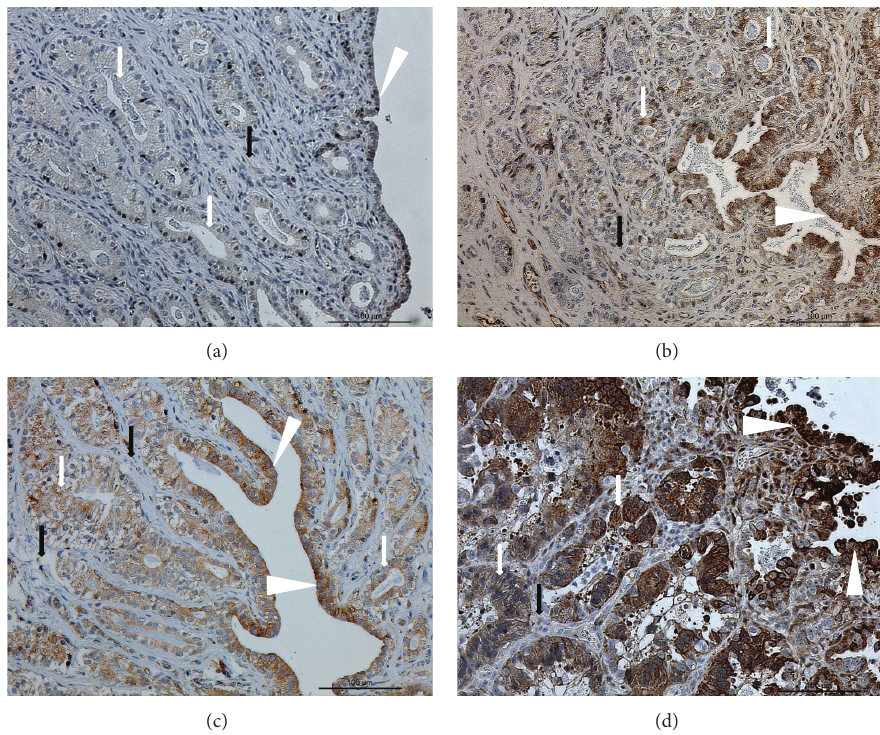
Figure 6: TNFR1 protein localization in endometria. Immunohistochemical (IHC) localization of TNFR1 in the endometria of cats collected at (a) estrus phase (E, 𝑛 = 7 ) and (b) diestrus phase (D, 𝑛 = 8 ) from (c) cats that had been treated with a P 4 derivative analog, medroxyprogesterone acetate (MPA, 𝑛 = 5 ); or (d) cats presenting the clinical symptoms of pyometra (PYO, 𝑛 = 3 ). (a) In females at estrus, only weak TNFR1 signals are localized in the glandular and surface epithelium; (b) in females at diestrus, positive staining is localized in the glandular and surface epithelium, similar to (c) MPA females; (d) in PYO females, strong signals are mostly localized in both the surface and the glandular epithelium. Surface epithelium: white arrowheads; glandular epithelium: white arrows; endometrial stroma: black